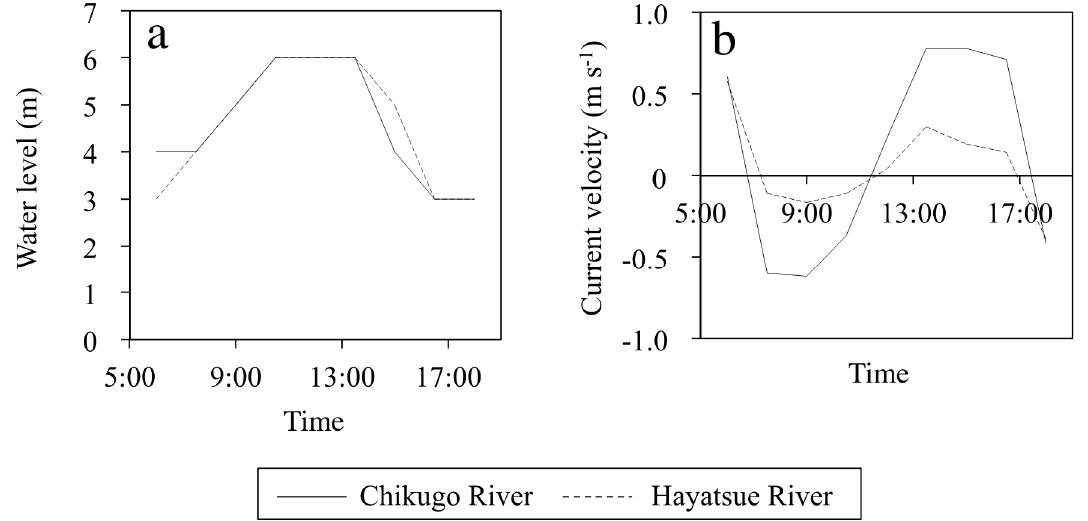
Figure 2. Variations in the ( a ) water level and ( b ) current velocity during the sampling period. A positive value of the current velocity means a southward velocity (outflow from rivers).